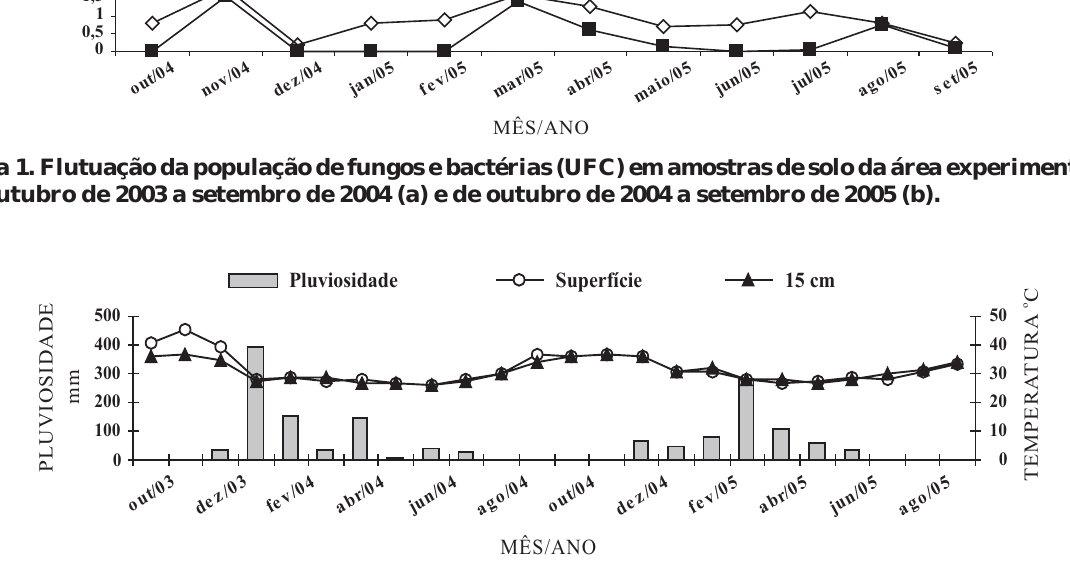
Figura 2. Pluviosidade média e temperaturas do solo na superfície e a 15,0 cm de profundidade, registradas de outubro/2003 a setembro/2005.